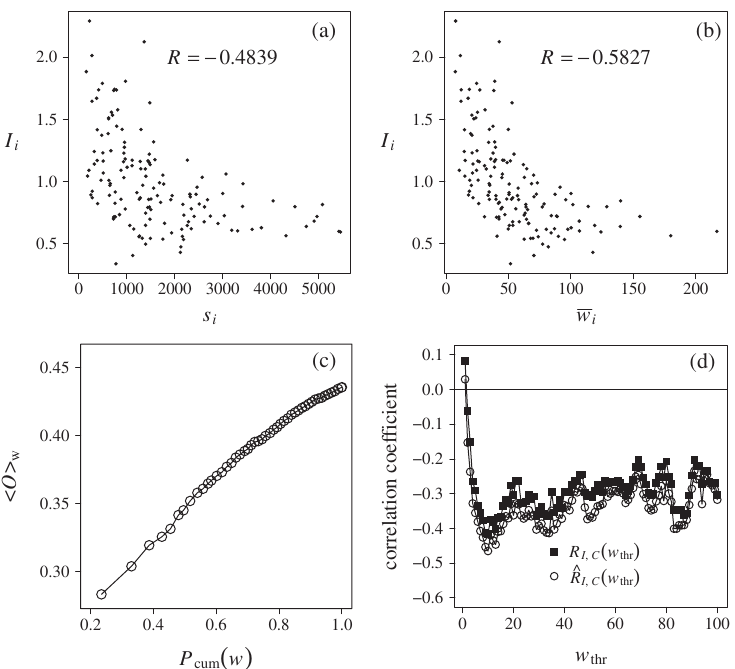
FIG. 15. Results when the link weight is defined by the total duration of the conversation events for each pair, for D information I i is plotted against (a) node strength s i and (b) average node weight (cid:1) w i . The Pearson correlation coefficient R between the plotted quantities is also shown. (c) Averaged neighborhood overlap h O i w as a function of the fraction of links with weights smaller than w . (d) Pearson correlation coefficient between I i and C i ð w ð w Þ and s ð w Þ fixed k i i thr thr